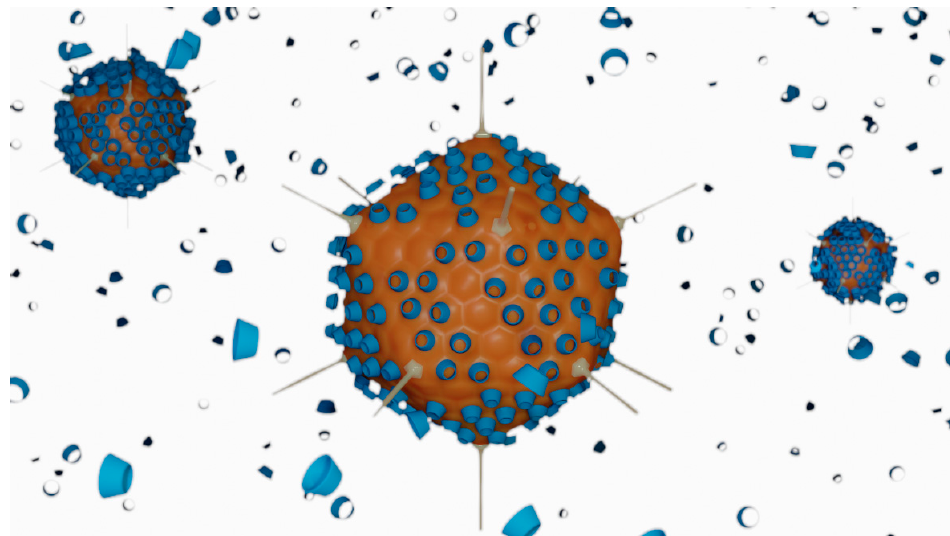
Figure 6. Schematic representation of the interactions between adenovirus particles (orange) and HP β CD molecules (blue) in the ad26.cov2.s vaccine. Cyclodextrin molecules are used in large excess and claimed to act as cryopreservatives, helping to stabilise the surface of the virus during the freeze-drying step of the vaccine preparation.